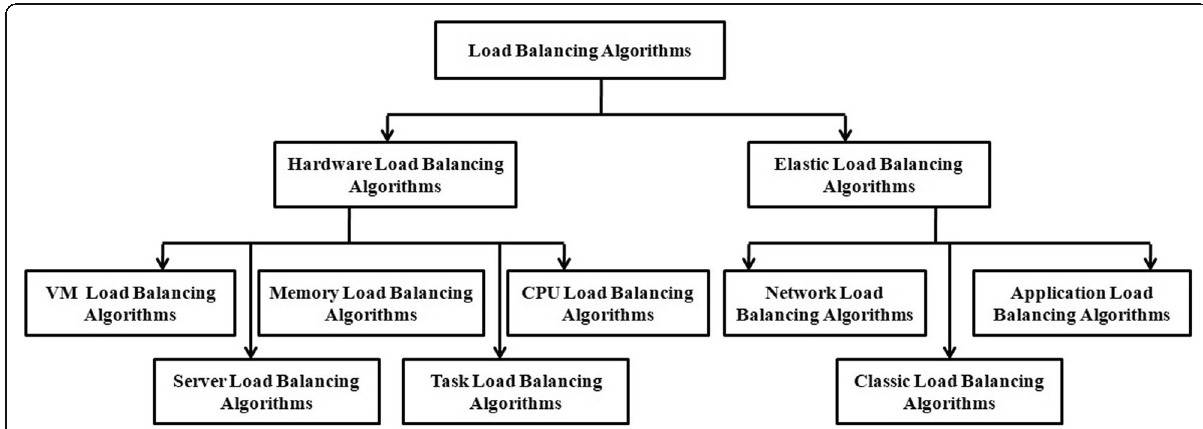
Fig. 5 Load balancing on the basis of functionality and